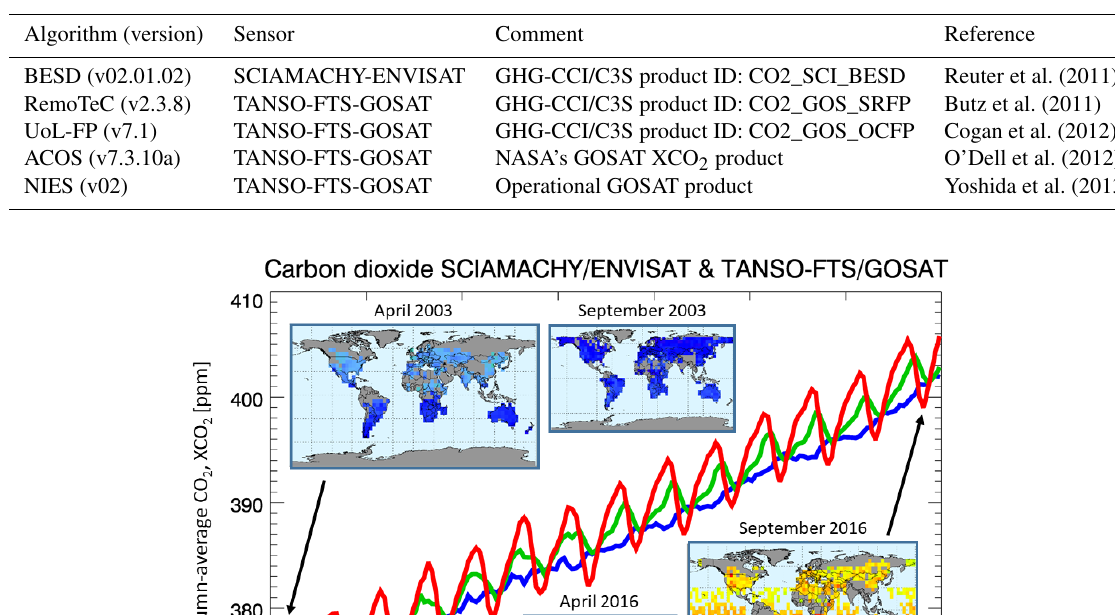
Table 1. Satellite XCO 2 data products. Individual satellite sensor XCO 2 algorithms and corresponding level 2 data products used for gen- erating the EMMAv3 level 2 (i.e. individual soundings) data product, which has been gridded to obtain the O4Mv3 level 3 data product used in this study. GHG-CCI refers to the GHG-CCI project of ESA’s Climate Change Initiative (http://www.esa-ghg-cci.org/, last access: